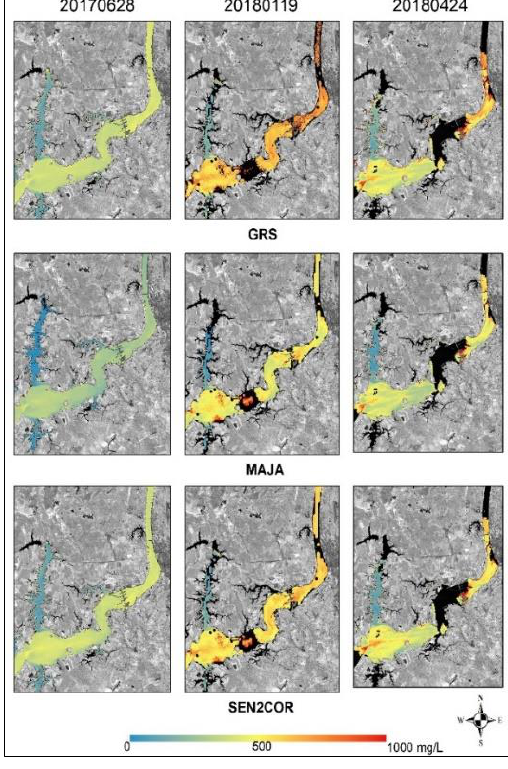
Figure 5 - Suspended sediment concentration estimates at the L1 sampling region (HPP Santo Antonio Reservoir) based on Sentinel-2 data using the three different atmospheric correction